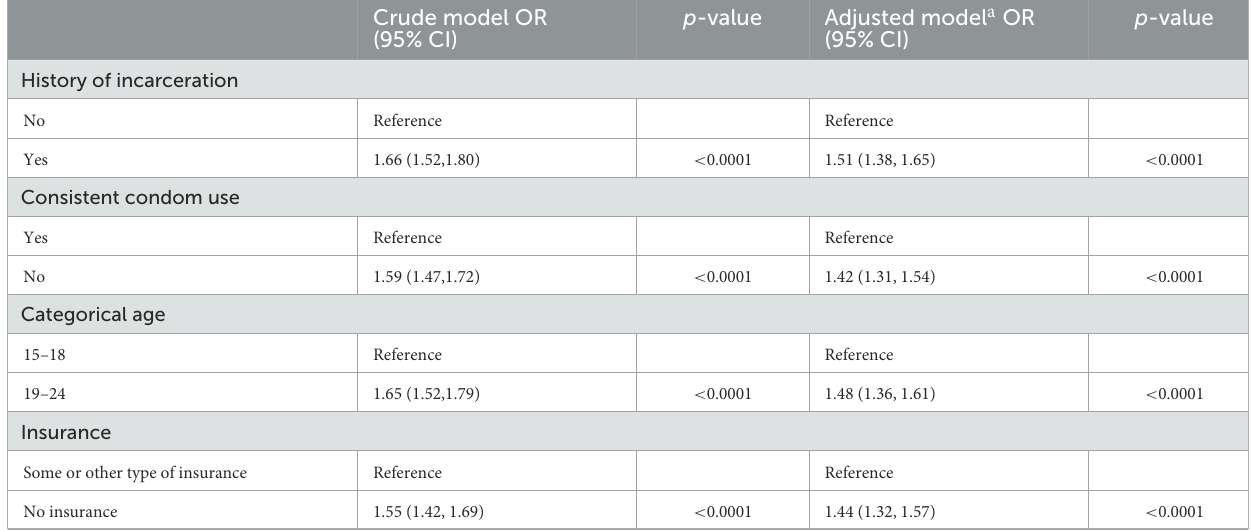
TABLE 5 Crude and adjusted associations for chlamydia outcomes and history of incarceration from sensitivity analysis. Crude model OR (95%